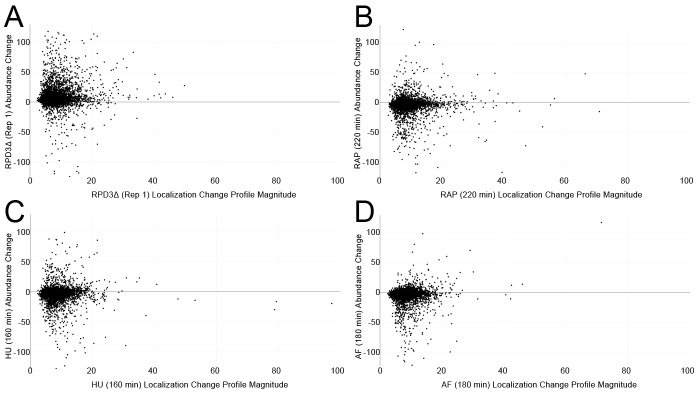
Scatterplots comparing the protein localization change profile magnitudes (calculated using the sum of squares over the features of the profile) with the average protein abundance change for each protein in four screens.(A) The first replicate of rpd3Δ. (B) 220 min of rapamycin treatment. (C) 160 min of hydroxyurea treatment. (D) 180 min of alpha factor treatment. See Materials and methods for details on how protein abundance change is calculated.